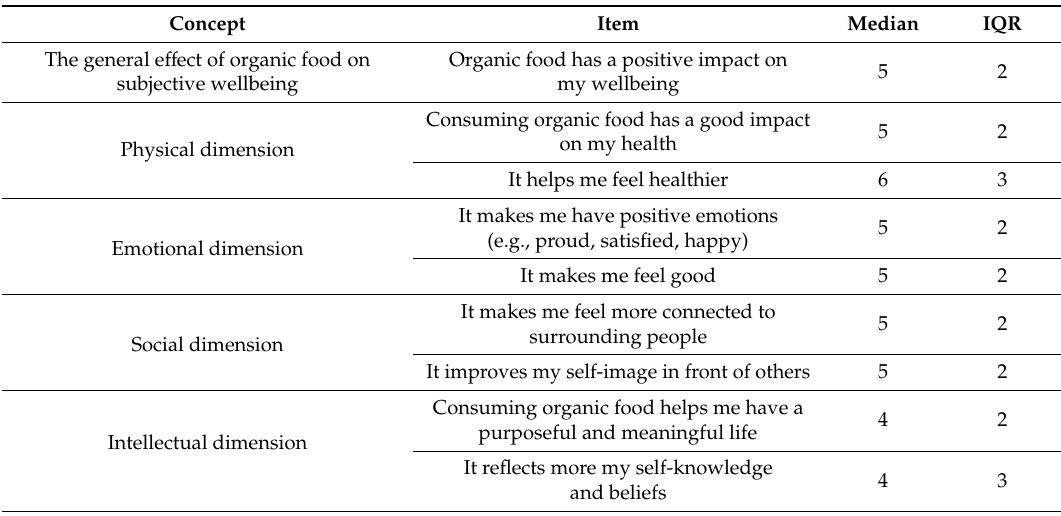
Table 9. The median and IQR values of the nine items used to study organic food impact on subjective wellbeing (1 = strongly disagree, 7 = strongly